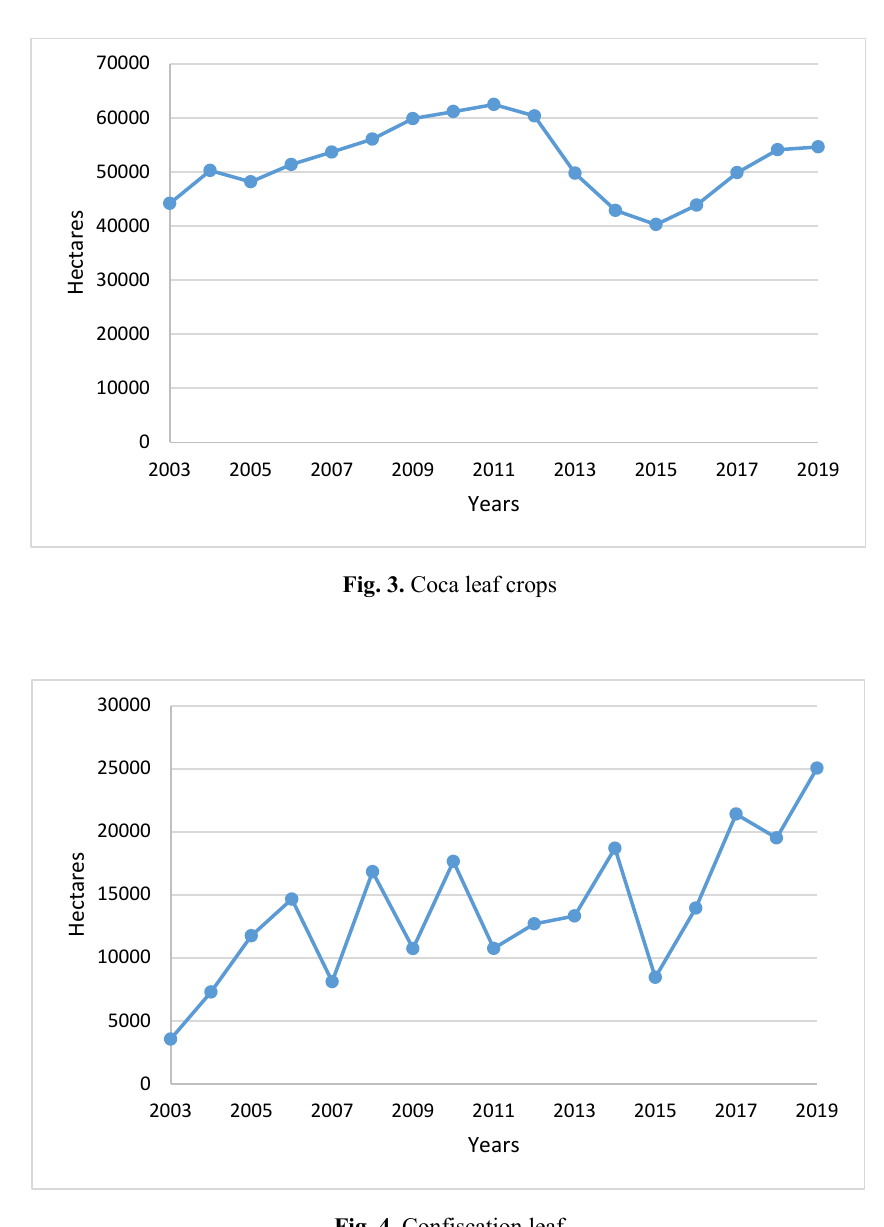
Fig. 4 . Confiscation